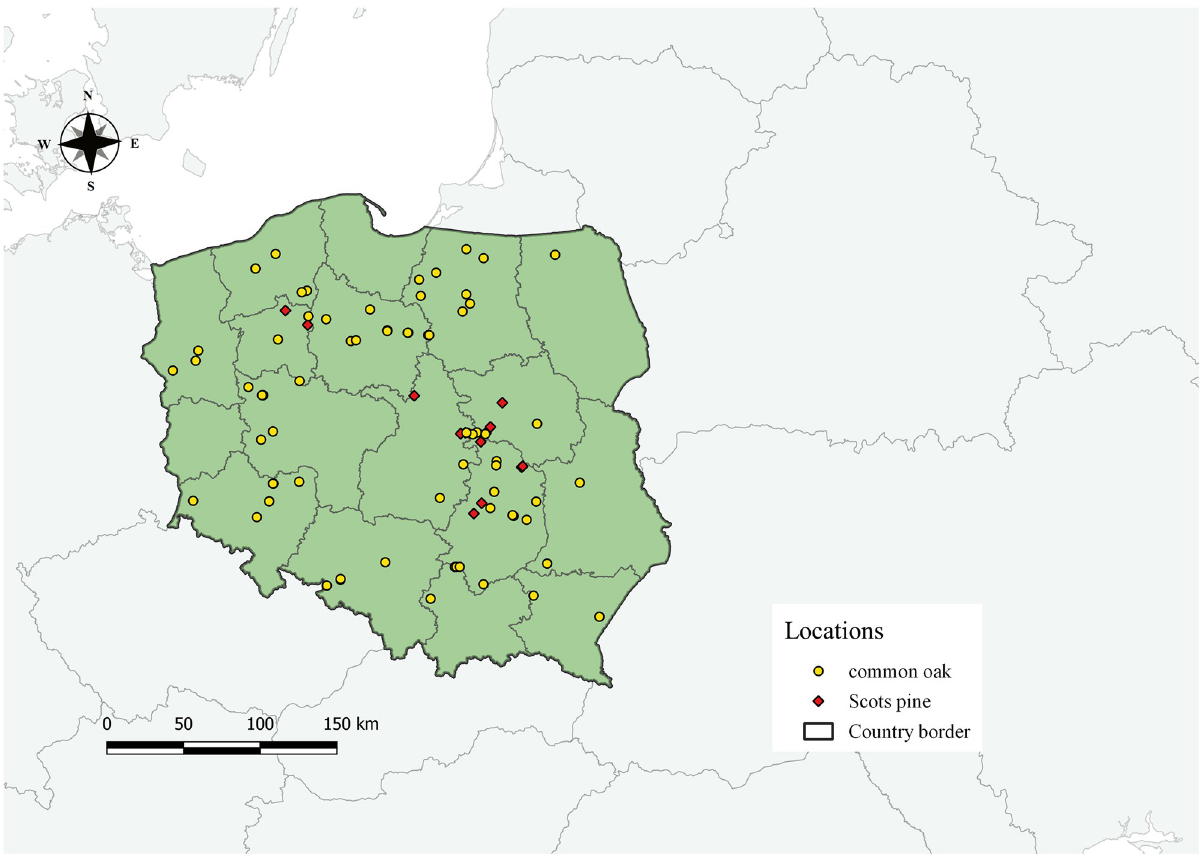
Fig 1. Selected sample plots distribution for scots pine and common oak in